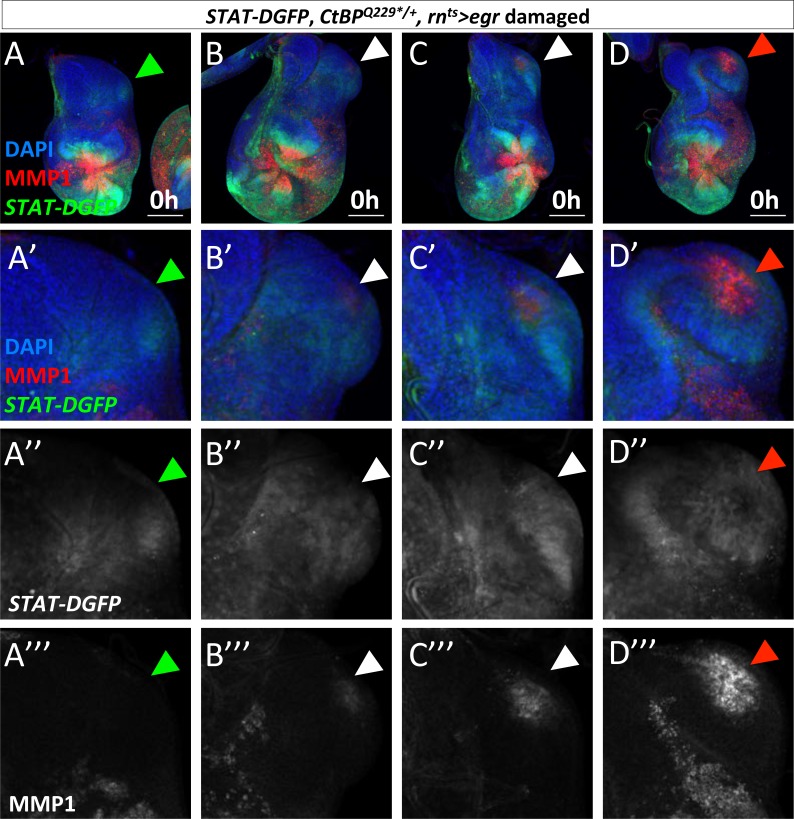
STAT-DGFP expression in the notum of damaged wing discs is independent of MMP1 expression.(A–D) Multiple examples of discs with variable amounts of STAT-DGFP and MMP1 expression in the notum. The green arrowheads (A–A’’’) point to a region in the notum with STAT-DGFP expression without detectable MMP1 protein. The white arrowheads (B–C’’’) show an example of a large patch of STAT-DGFP expression with only small region of MMP1 expression. The red arrowheads (D–D’’’) show a high level of MMP1 expression within a region of STAT-DGFP expression. Note that the STAT-DGFP expression appears lower where it overlaps with MMP1 expression.